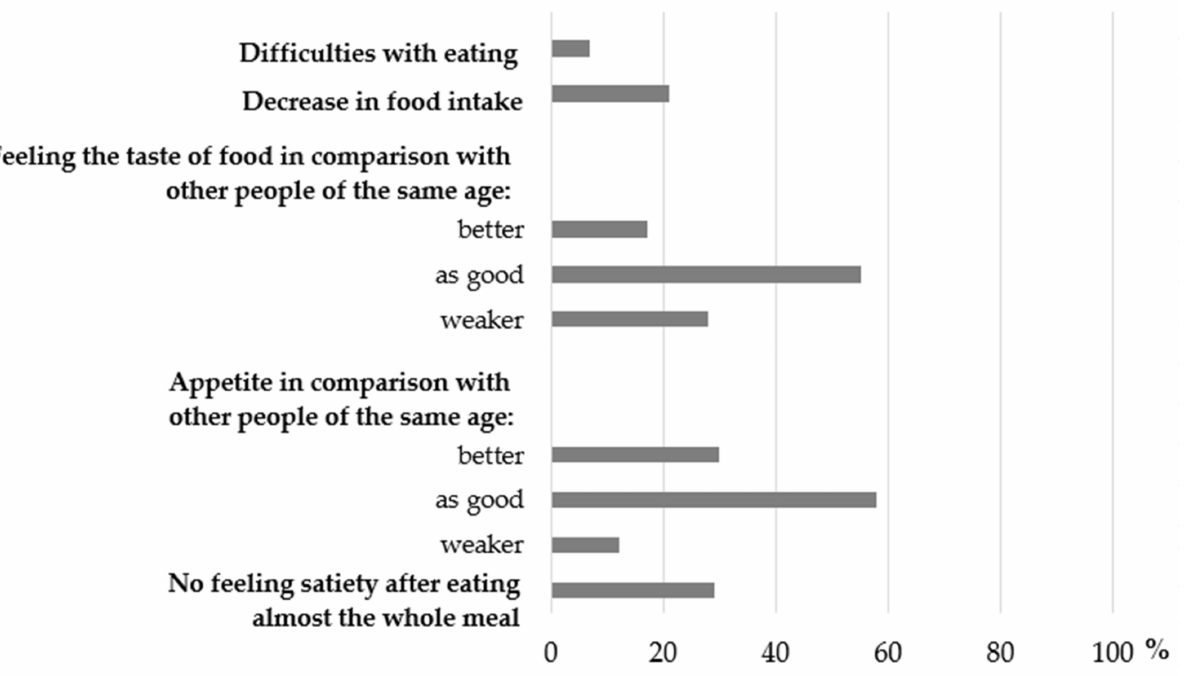
Figure 3. Distribution of the components of the Eating-related Limitations Score (percentage of the total